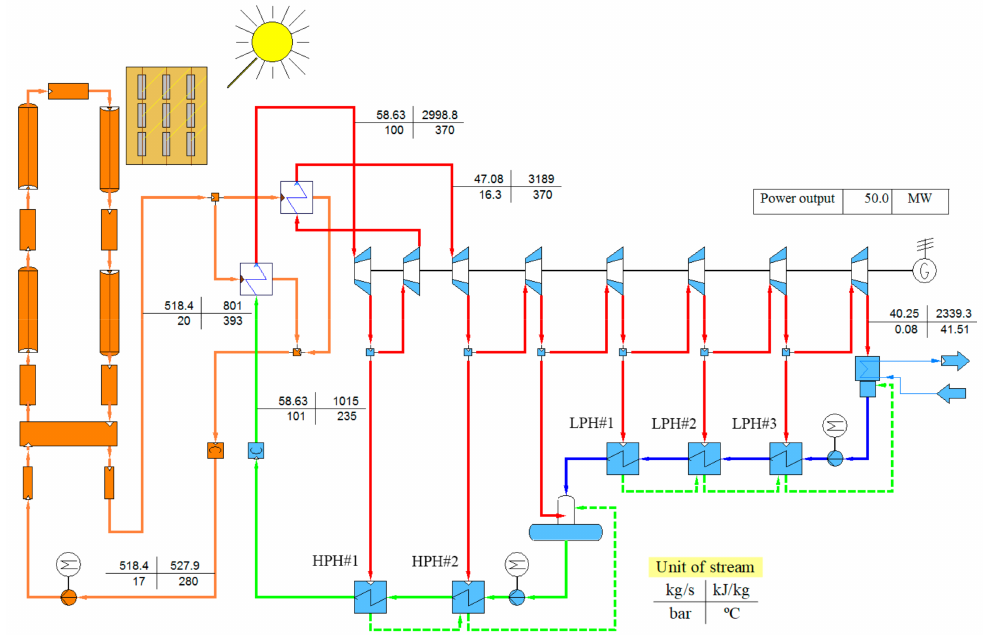
Figure 5. The model of the process flow diagram of the 50 MW CSP plant (IPSEpro